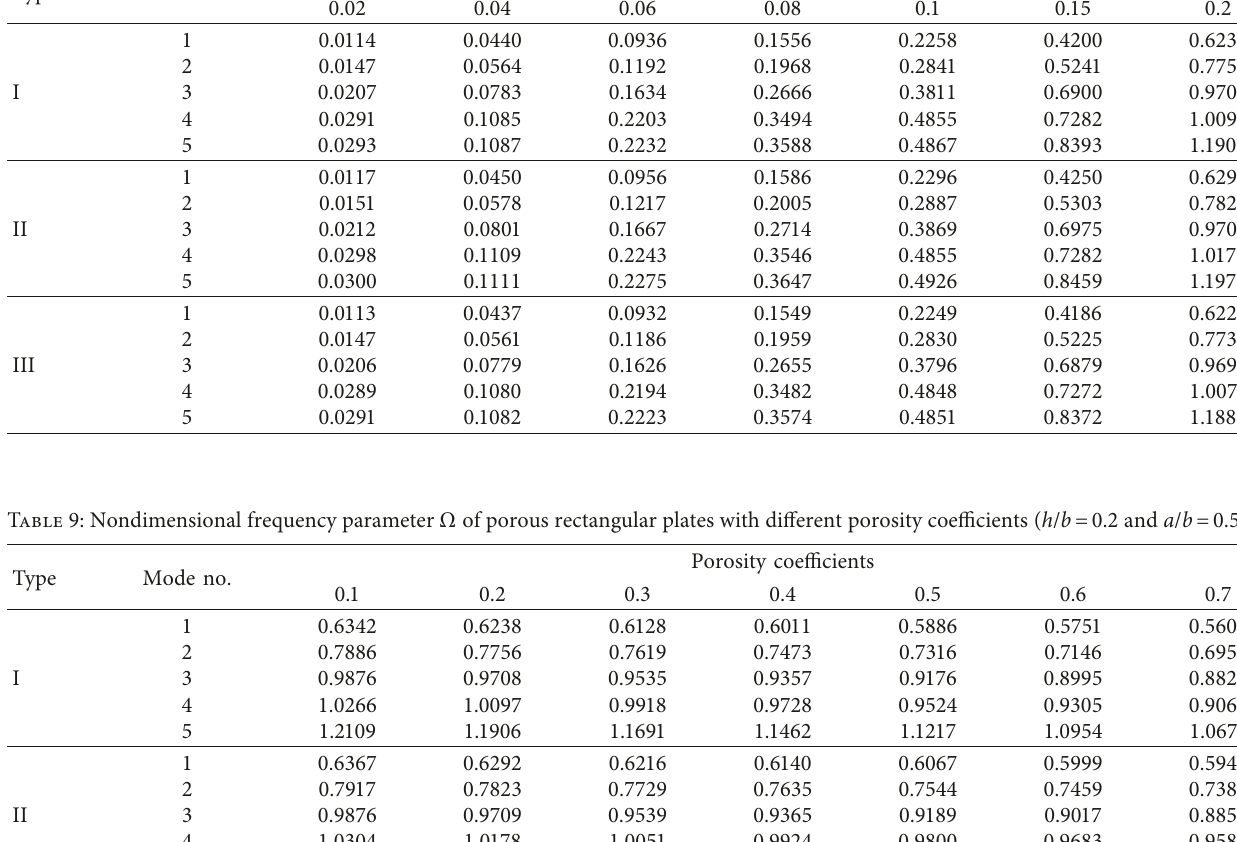
Table 8: Nondimensional frequency parameter Ω for porous rectangular plates with different thickness ratios h / b ( e � 0.2 and a / b � 0.5). Type Mode no.